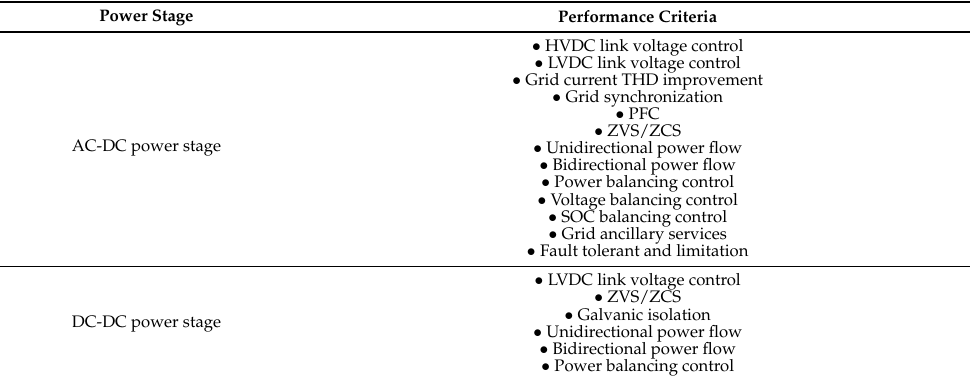
Table 5. The desired performance of a SST-based DC ultra-fast charging